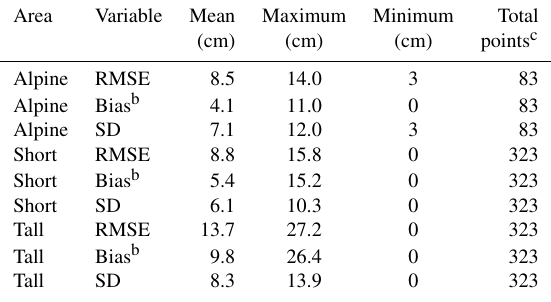
Table 3. Absolute snow depth accuracy summary a